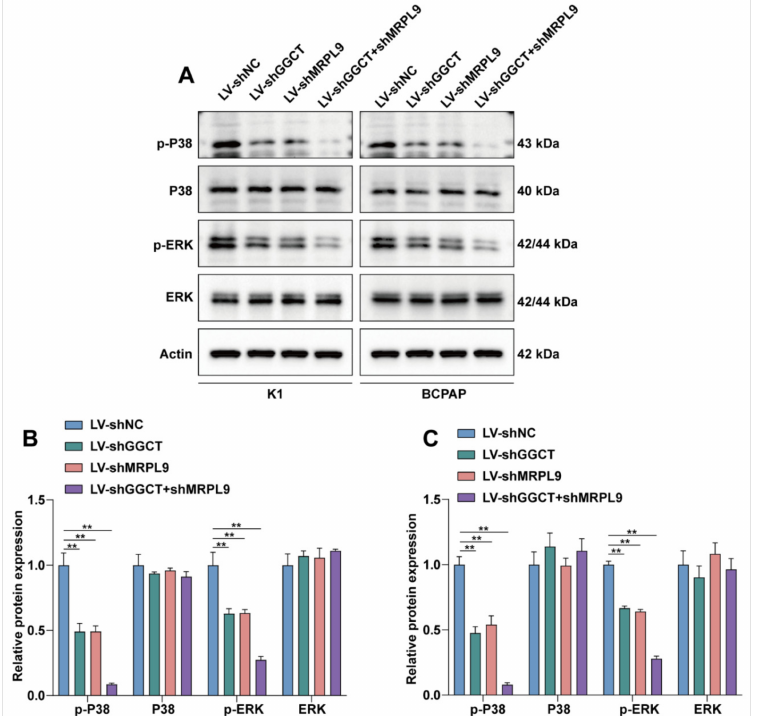
Figure 5. GGCT regulates the MAPK/ERK signaling pathway by interacting with MRPL9. ( A ). The protein expression levels of P38, p-P38, ERK and p-ERK in the shGGCT/shMRPL9/sh-GGCT + shMRPL9 group were detected by Western blot in K1/BCPAP cells. ( B ) The expression levels of P38, p-P38, ERK and p-ERK in the shGGCT/shMRPL9/sh-GGCT + shMRPL9 group in K1 cell line were analyzed by J image, normalized to Actin ( n = 3). ( C ) The expression levels of P38, p-P38, ERK and p-ERK in the shGGCT/shMRPL9/sh-GGCT+shMRPL9 group in BCPAP cell line were analyzed by J image, normalized to Actin ( n = 3) Measurement data (mean ± standard deviation) between two groups were compared by paired t test. “**” represents p ≤